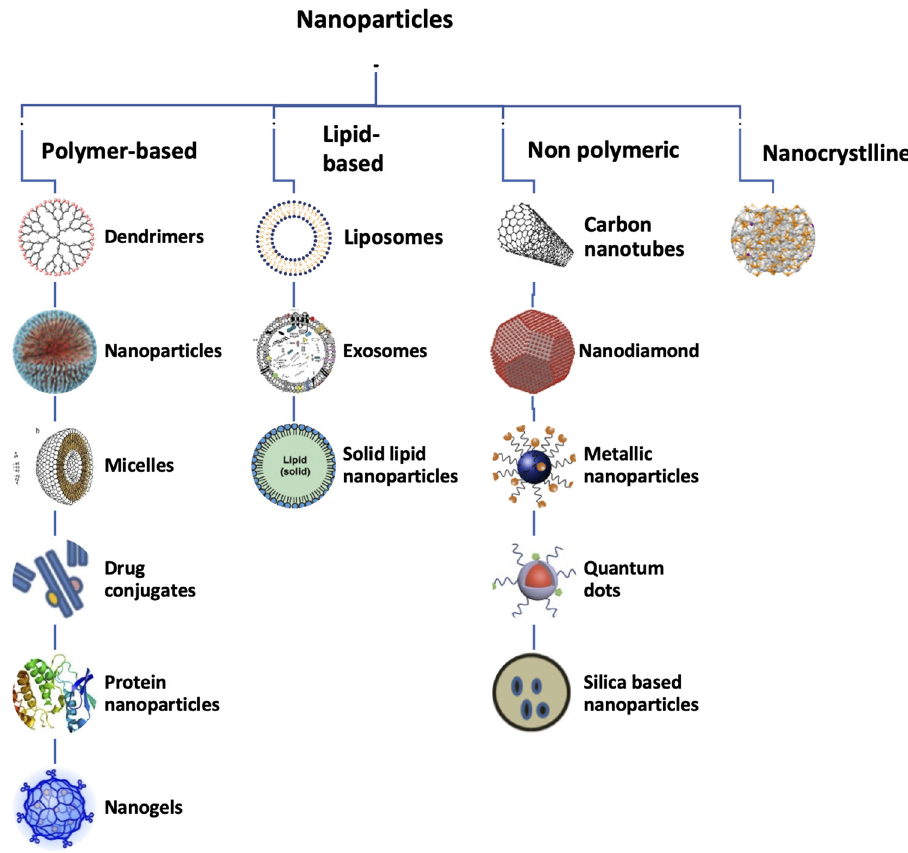
Figure 1: Schematic diagram representing the di ff erent types of nanoparticles due to varying types of